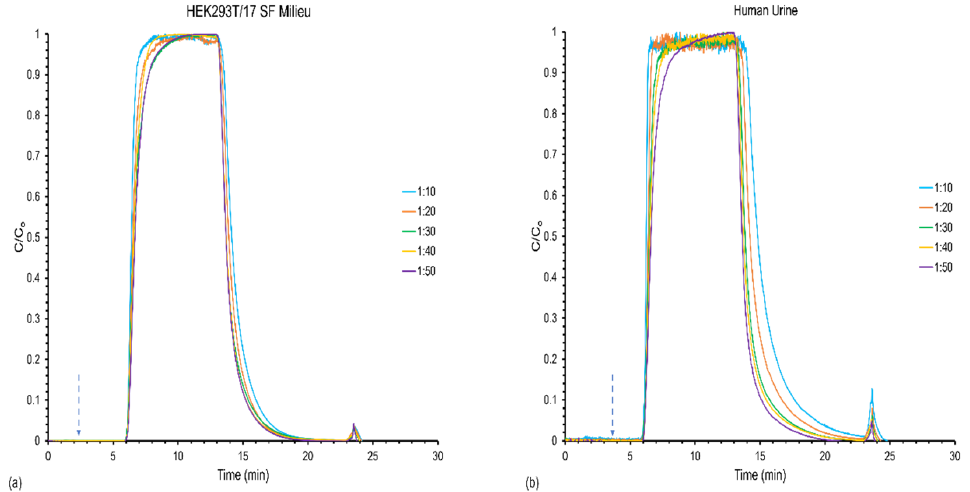
Figure 2. Frontal load and recovery response for varying the EV loading concentrations of the ( a ) HEK293T/17 SF milieu and ( b ) human urine samples at a constant load and elution flow rate of 0.5 mL min − 1 .